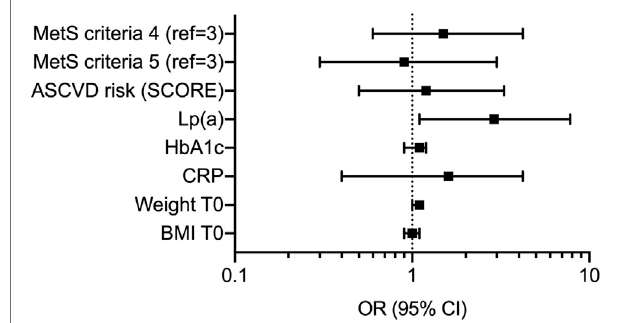
FIGURE 1 | Forest plot reporting logistic regression analysis for clinical and biochemical variables associated with more severe carotid atherosclerosis. Data are presented as odds ratio (OR) with 95% con fi dence interval (CI). MetS, metabolic syndrome; ASCVD, atherosclerotic